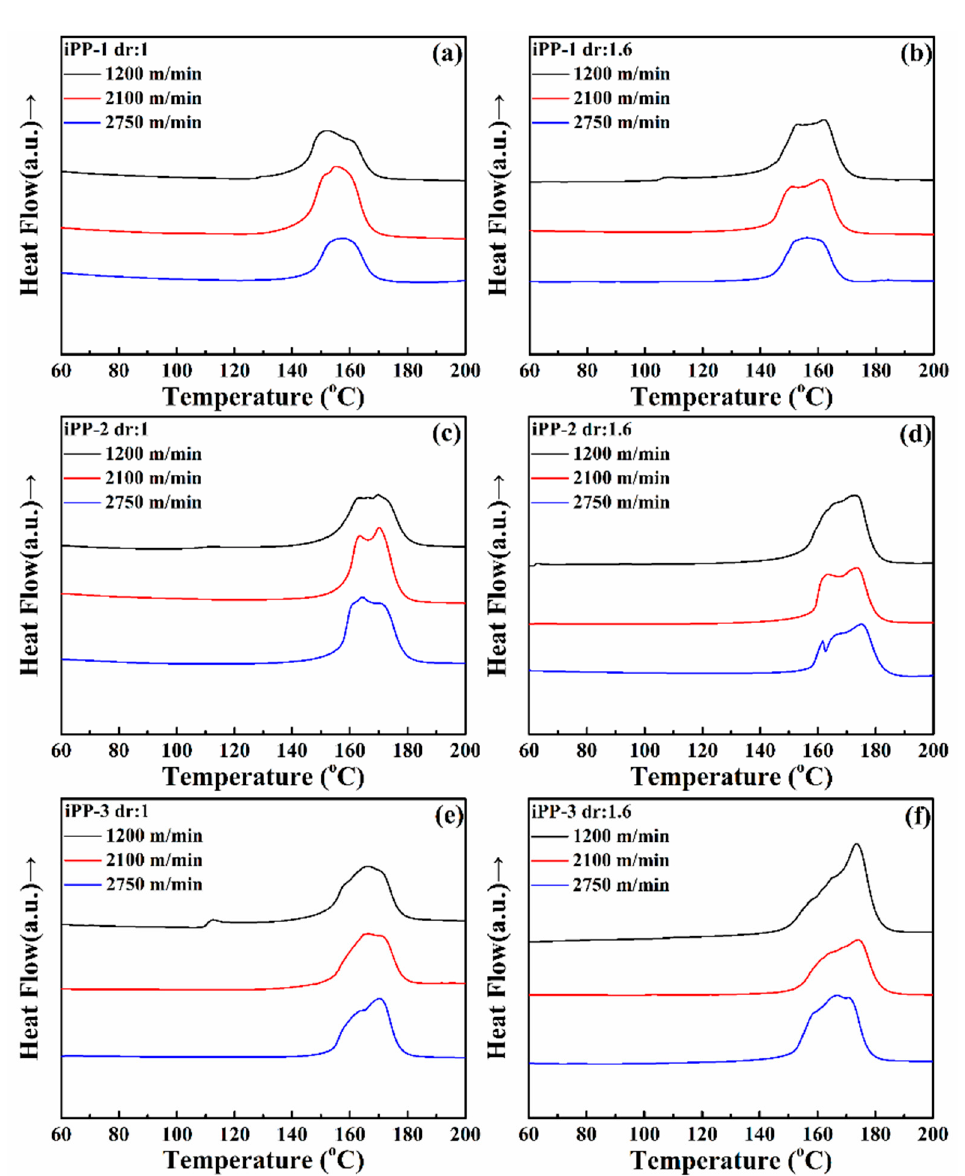
Figure 6. DSC thermograms of ( a ), ( c ), ( e ) as-spun and ( b ), ( d ), ( f ) drawn iPP fibers.